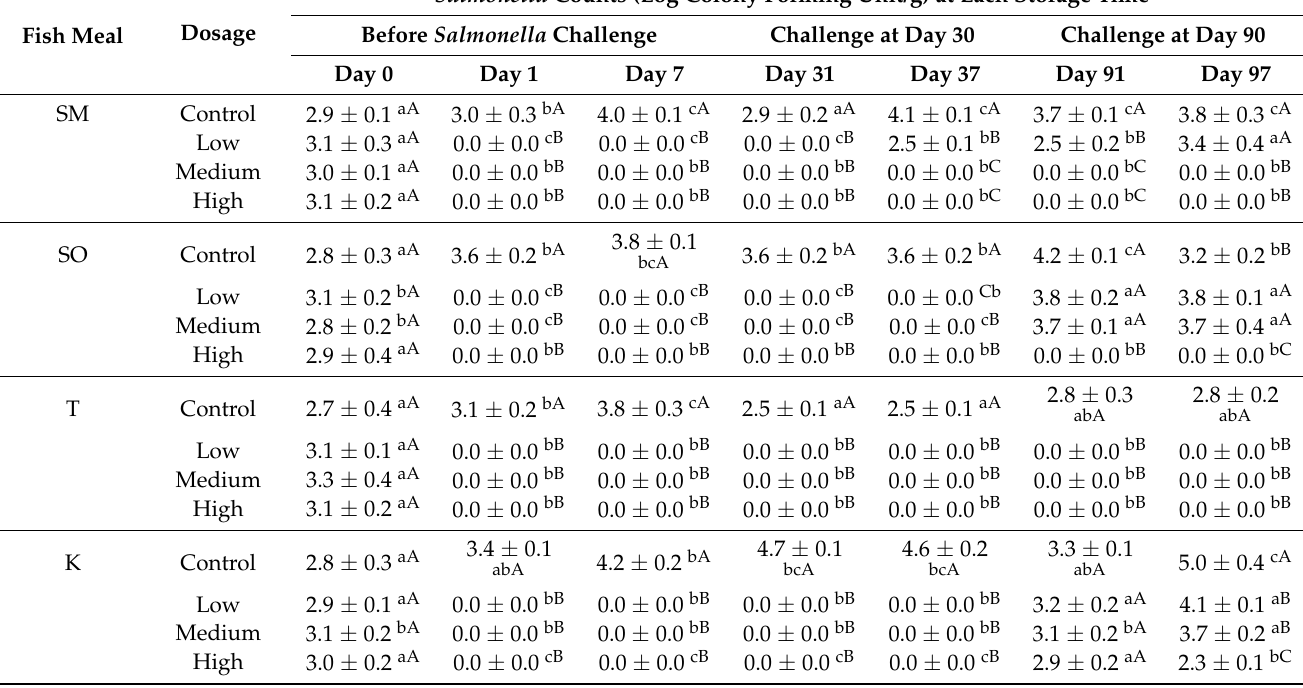
Table 3. Inhibitory effects of SALTEC 514 TM against Salmonella recontamination in fish meal. Salmonella Counts (Log Colony Forming Unit/g) at Each Storage Time 1 Before Salmonella Fish Meal Dosage